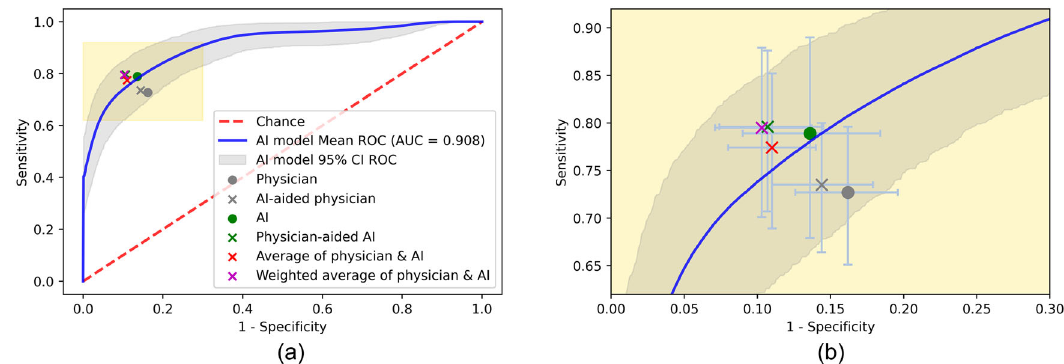
Fig. 3 Average performance of physicians, AI, and four collaborative strategies. Receiver operating characteristic (ROC) curve of our AI model versus the performance of other strategies in ARDS detection. Markers denote each strategy ’ s performance in terms of sensitivity and 1-speci fi city along with their 95%